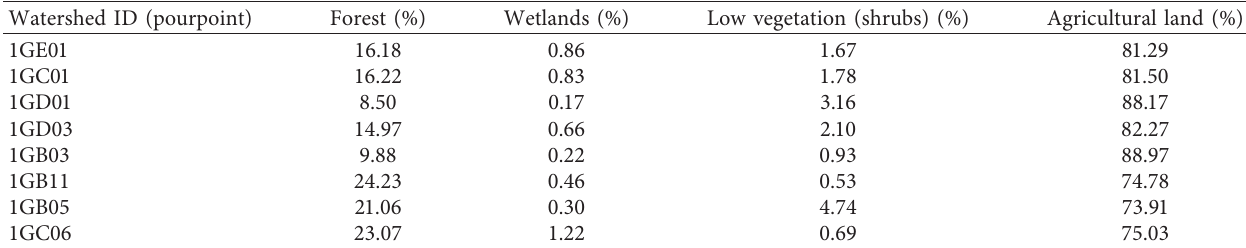
Table 1: LULC in percent for the eight (8) sub-basins corresponding to the studied stations. Watershed ID (pourpoint) Forest